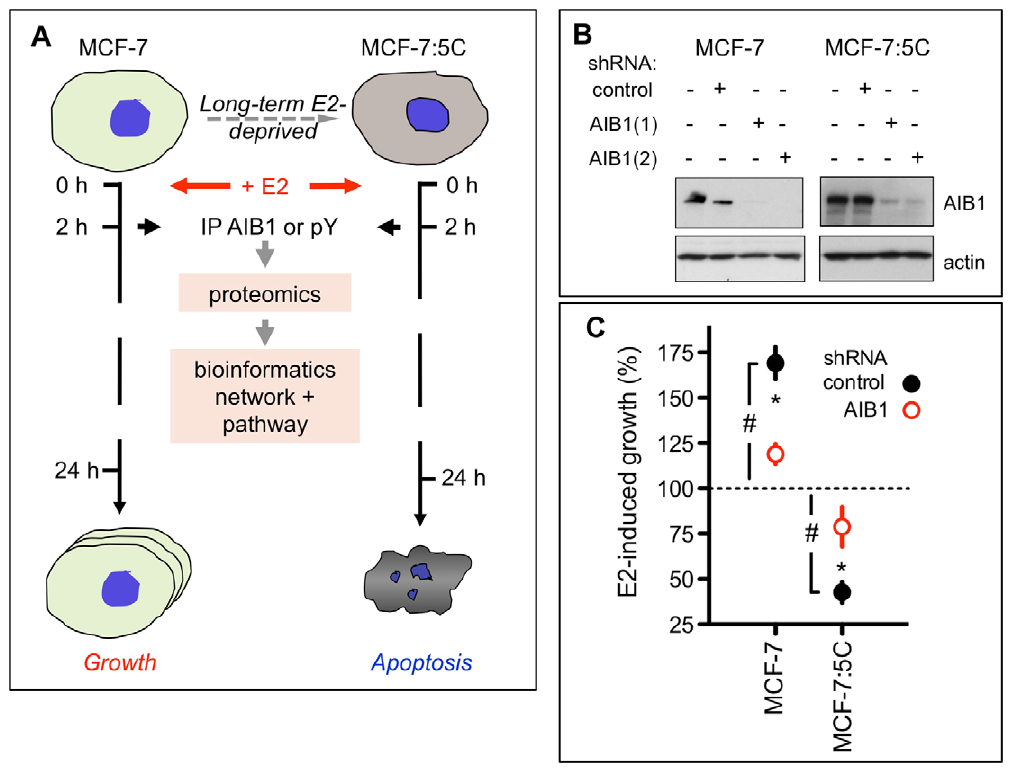
Figure 1. Phenotypic impact of AIB1 depletion on estradiol (E2) growth response in MCF-7 or MCF-7:5C cells. ( A ) The experimental paradigm. The differential responses to estradiol (E2) treatment of MCF-7 (cell growth) and long-term estrogen deprived MCF-7:5C cells (apoptosis) are indicated. Proteomics profiles of the two cell lines at baseline and after a brief (2 h) E2 treatment were generated using immunoprecipitations (IP). Proteins interacting with AIB1 or phosphotyrosine containing protein complexes were isolated by IP followed by mass spectrometry. Data were then subjected to an integrated bioinformatics analysis of signaling pathways and protein networks. ( B,C ) Reversal of E2-dependent effects on MCF-7 and MCF-7:5C after depletion of endogenous AIB1 protein using two different lentiviral shRNAs. MCF-7 or MCF-7:5C cells were infected with lentiviral particles expressing control or AIB1-targeting shRNAs. (B) RNAi-mediated knockdown was assayed by Western blot analysis for AIB1 relative to an actin loading control. (C) Cell growth was assayed 6 days after plating without or with E2. The E2 effect is shown relative to the respective untreated controls (mean 6 S.E.M.). Closed circles: control shRNA; Open circles (red): AIB1 shRNA. # , p , 0.05 E2 treatment effect vs. no treatment in control shRNA cells; *, p , 0.05 E2 treatment effect in control shRNA cells vs. E2 treatment in AIB1 depleted cells. Representative data from one of at least three independent experiments are shown.